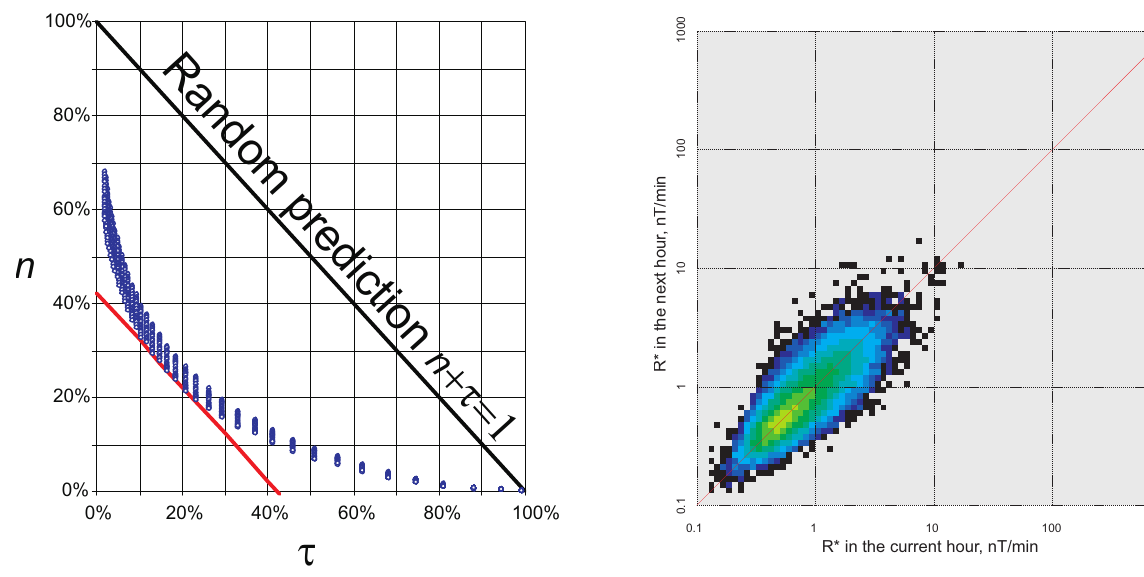
Fig. 7. The error diagram for CLF (hourly means).